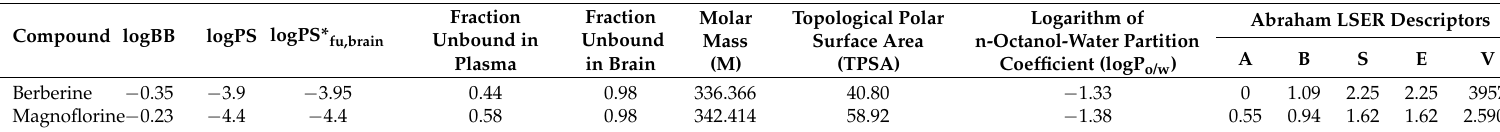
Table 1. The collation of the blood–brain barrier (BBB) pharmacokinetic parameters, the Abraham linear solvation energy relationship (LSER) descriptors and the chosen physicochemical